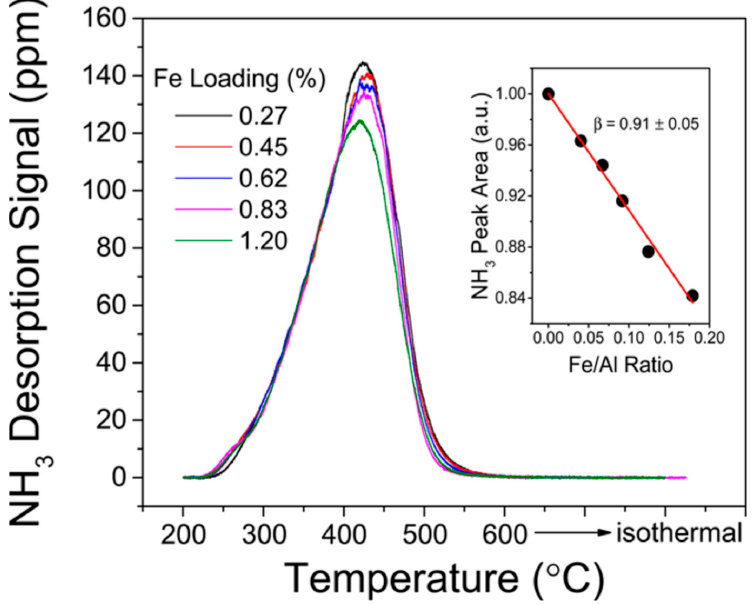
Figure 5. NH 3 -TPD curves for the parent H/SSZ-13 and the Fe/SSZ-13 samples. NH 3 adsorption and purging was carried out at 100 °C prior to TPD. The inset shows a linear fit between normalized NH 3 desorption peak areas versus Fe/Al ratios. Reprinted with permission from [28]. Copyright © 2016 American Chemical Society.